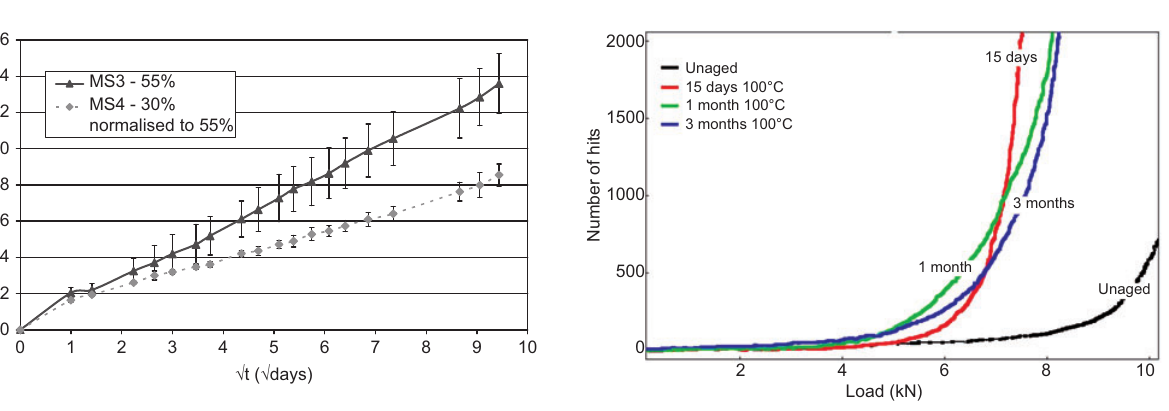
Figure 15 Acoustic emission activity of MS4 during ageing [num- ber of hits vs. load (kN/10)].